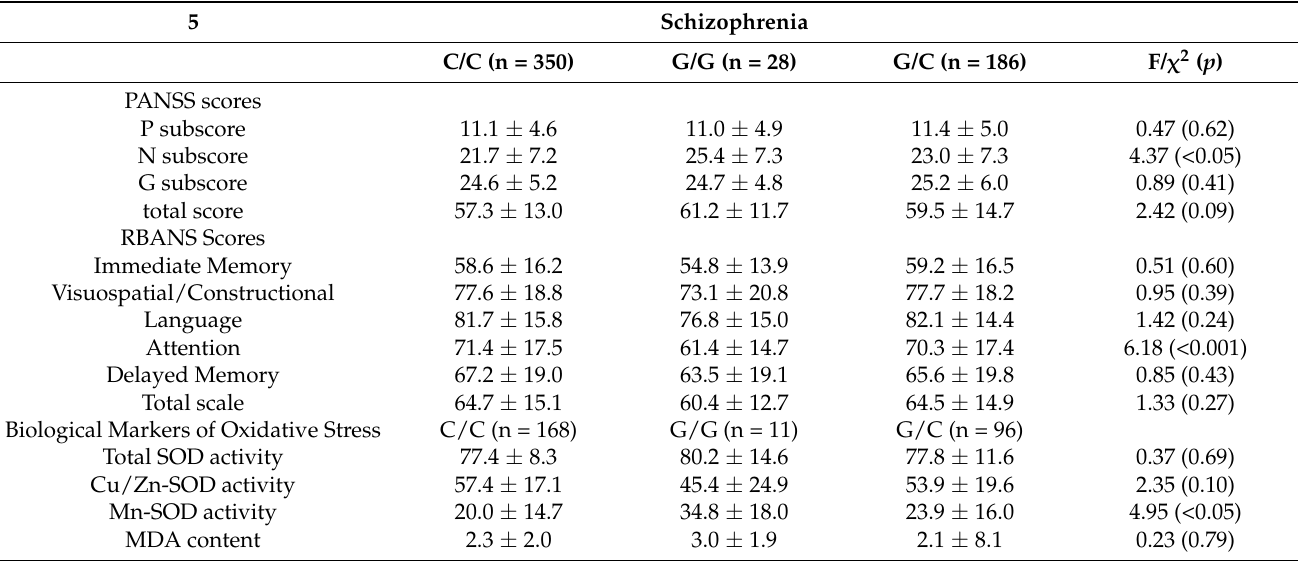
Table 2. Genotypic effects on psychotic symptoms, cognitive functions, and biological markers of oxidative stress in